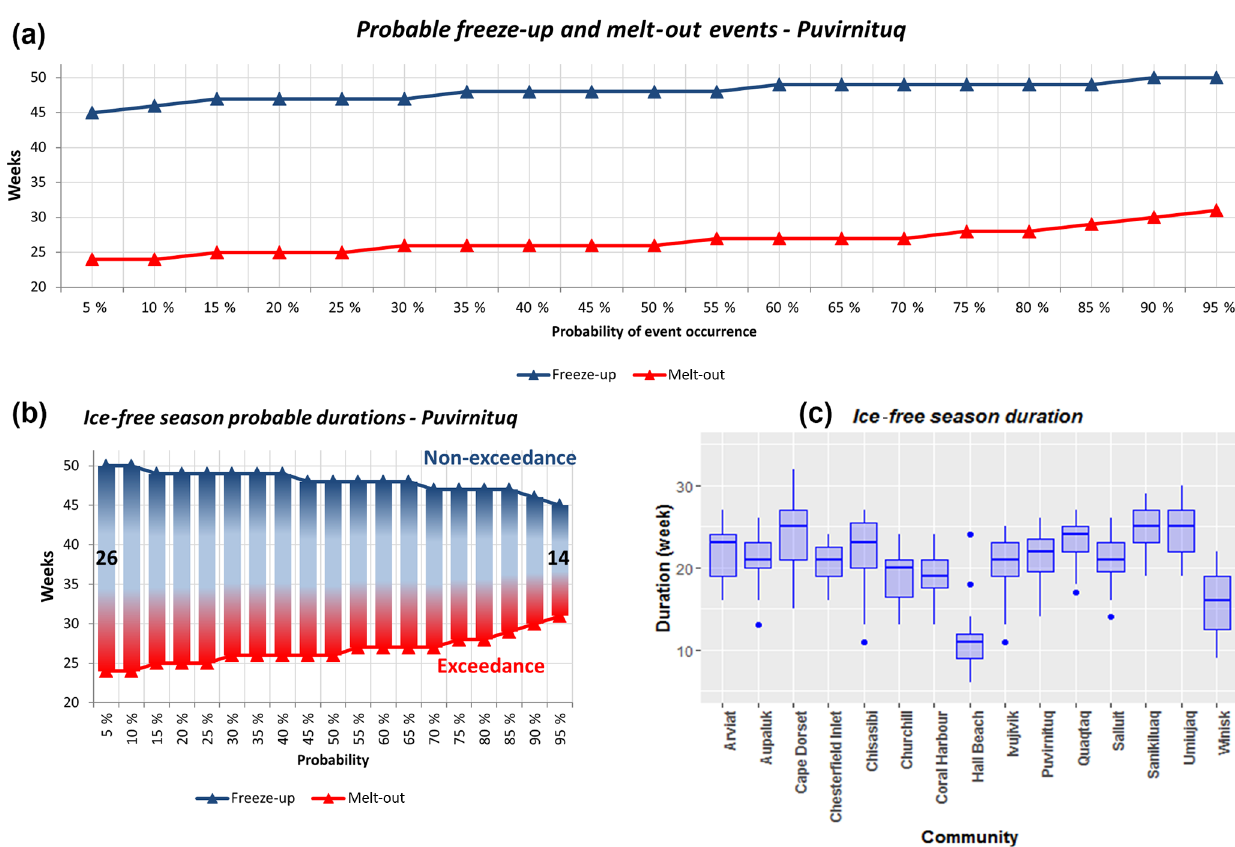
Figure 9. Probable freeze-up and melt-out events for the coastal community of Puvirnituq (a) , the range of probable ice-free season duration for the same community (b) , and probable ice-free season lengths for all coastal communities of the HBS (c)